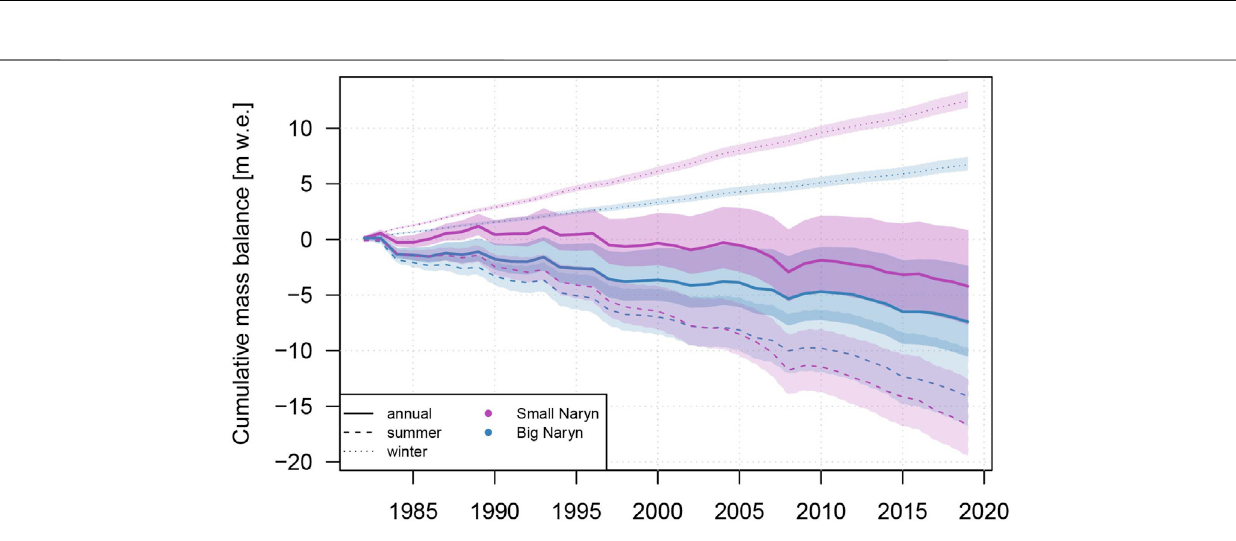
Frontiers in Environmental Science |